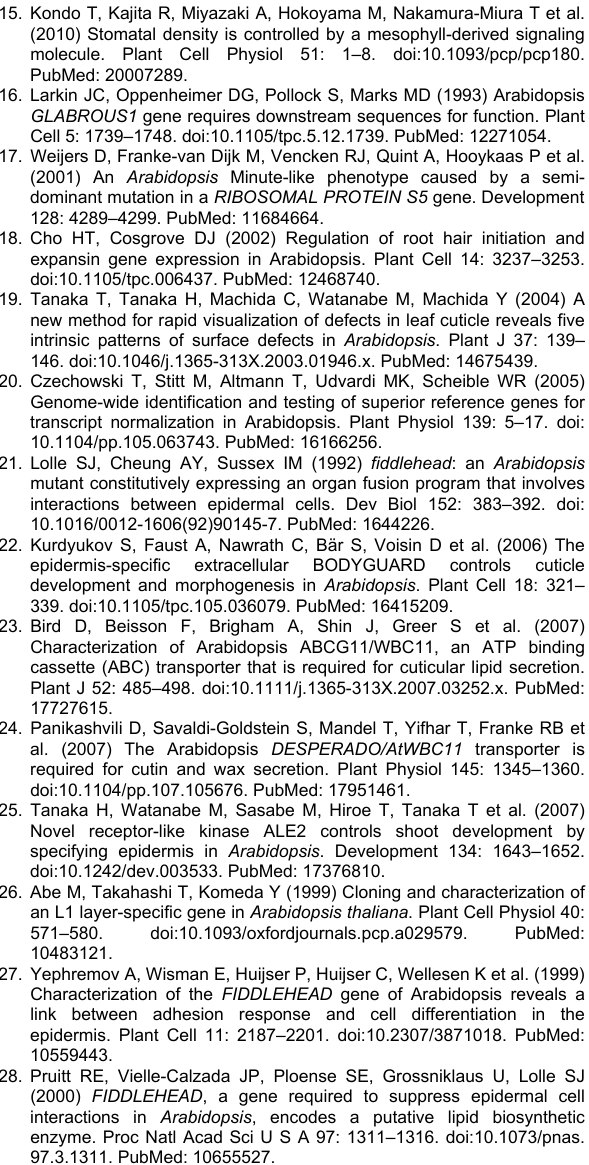
Figure S1. Effect of ATML1-SRDX on cell arrangement in the cotyledons. Longitudinal sections of cotyledons from 7- day-old seedlings of the wild type (A) and ATML1-SRDX line 1 (B) grown with 10 μM estradiol and stained with toluidine blue. Scale bars, 100 μm.